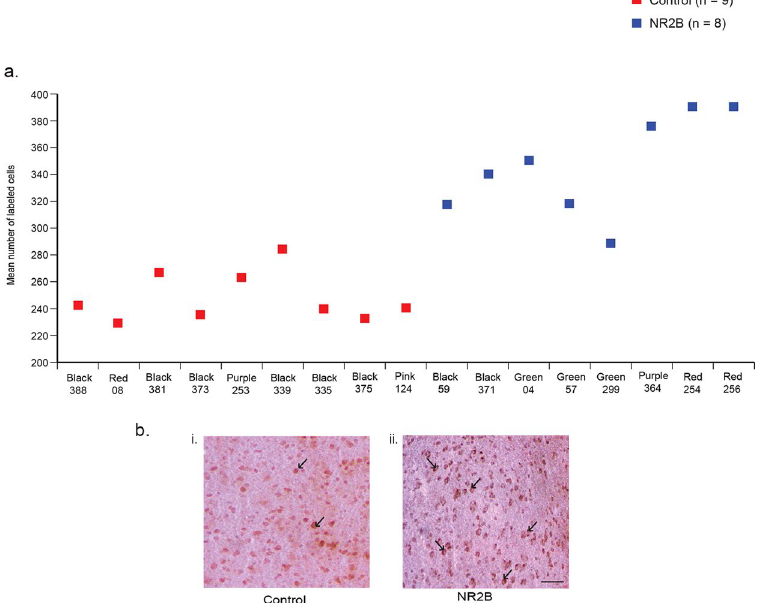
Figure 3. Immunostaining of NR2B protein in LMAN cells. ( a ) Quantification showing higher levels of labeled cells in birds injected with the eGFPhNR2B lentivirus in LMAN (blue) compared to control birds with injections of the eGFPhNR2B lentivirus in nidopallium or the eGFP lentivirus in LMAN (red). Control-injected animals did not differ in number of labeled cells (p = 0.73, two sample Wilcoxon test). ( b ) Examples of labeled LMAN cells in eGFP-injected animals (i), and in eGFPhNR2B-injected animals (ii). Scale bar, 200 μ